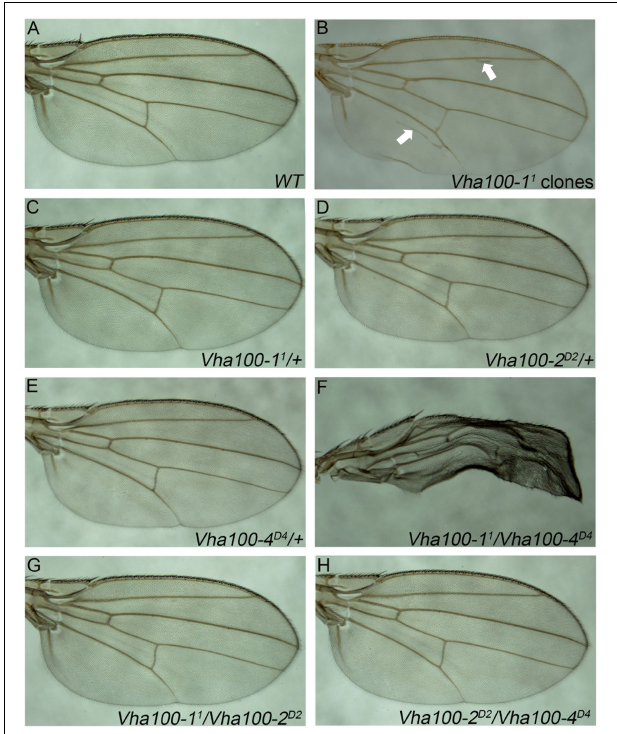
FIGURE 5 | Vha100-1 and Vha100-4 perform redundant functions during fly wing development. (A,B) The adult wing of W 1118 stock is used as wild type control (A) . Ectopic veins (marked by arrows) are formed in wings bearing Vha100-1 1 mutant clones (B) . (C–H) Compensation tests among Vha100-1 , Vha100-2, and Vha100-4 . The adult wings of heterozygous Vha100-1 1 (C) , Vha100-2 D2 (D) , and Vha100-4 D4 (E) flies are indistinguishable from wild type controls. Trans -heterozygous Vha100-1 1 /Vha100-4 D4 flies show severe wing developmental defects (F) . Wings of Vha100-2 D2 / Vha100-1 1 (G) and Vha100-2 D2 / Vha100-4 D4 (H) flies display normal developmental patterns. Scale bars: 0.5